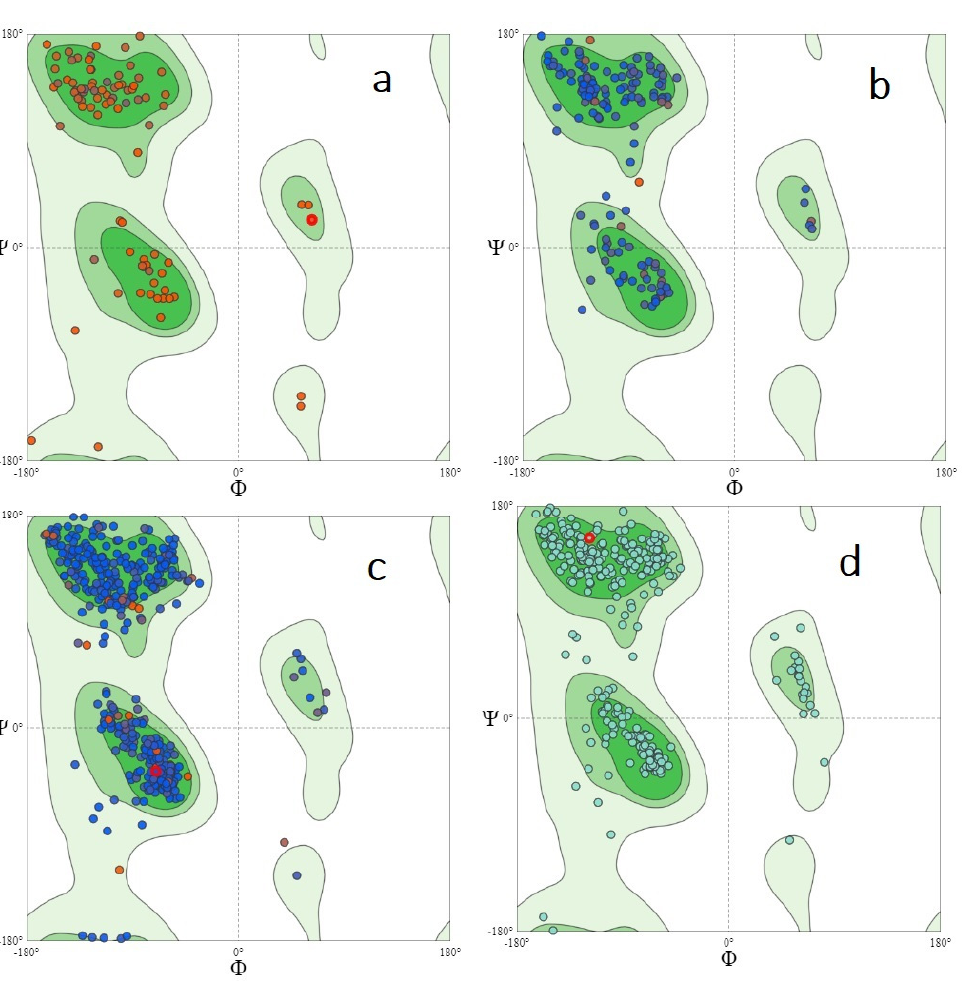
General Glycine